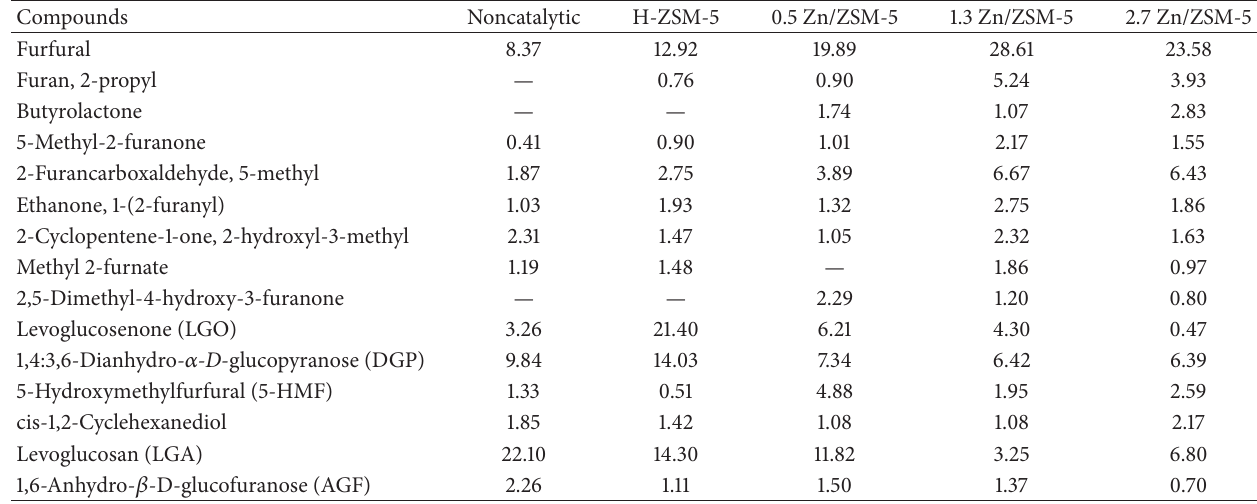
Table 3: The component analysis of the biooils derived from noncatalytic and catalytic pyrolysis of cellulose at 400 ∘ C (peak area% in the MS).